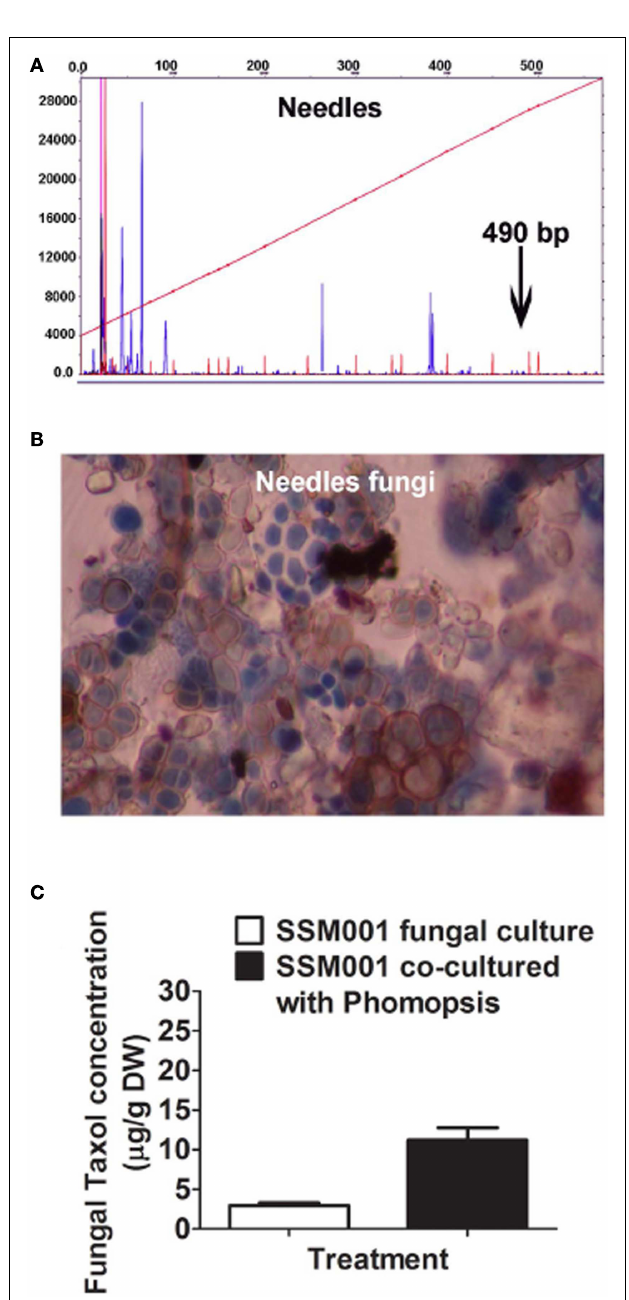
FIGURE 3 | Co-habitating fungi present in Taxus x media needles stimulateTaxol production from Paraconiothyrium SSM001 fungi. (A) tRFLP analysis of DNA pooled from Taxus needles showing several fungal peaks, none of which corresponded to SSM001. (B) Detection of different fungal spores from T. x media needles. (C) Effect of co-culturing of pure Phomopsis fungus isolated from Taxus needles with SSM001 in liquid